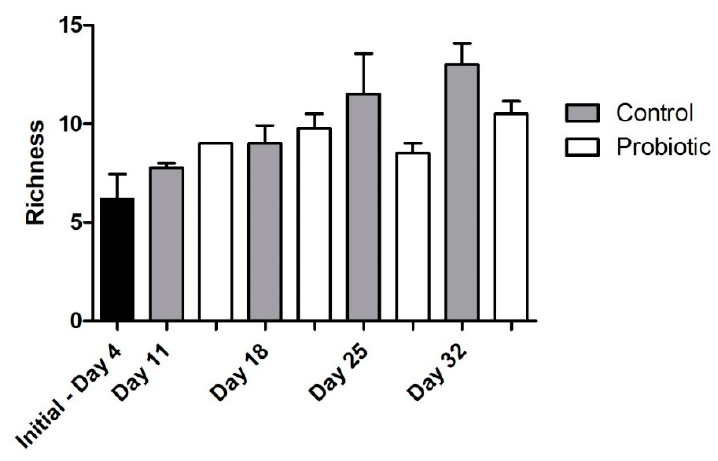
Figure 4. Microbial richness during seabass larvae development as indicated by denaturing gradient gel electrophoresis (DGGE) analysis (bar plots show the number of different bands) between the control and the probiotic treatment. Two-way ANOVA was performed (treatment and time), showing a significant effect of developmental stage ( p = 0.004), but not probiotic administration in the microbial community over time.